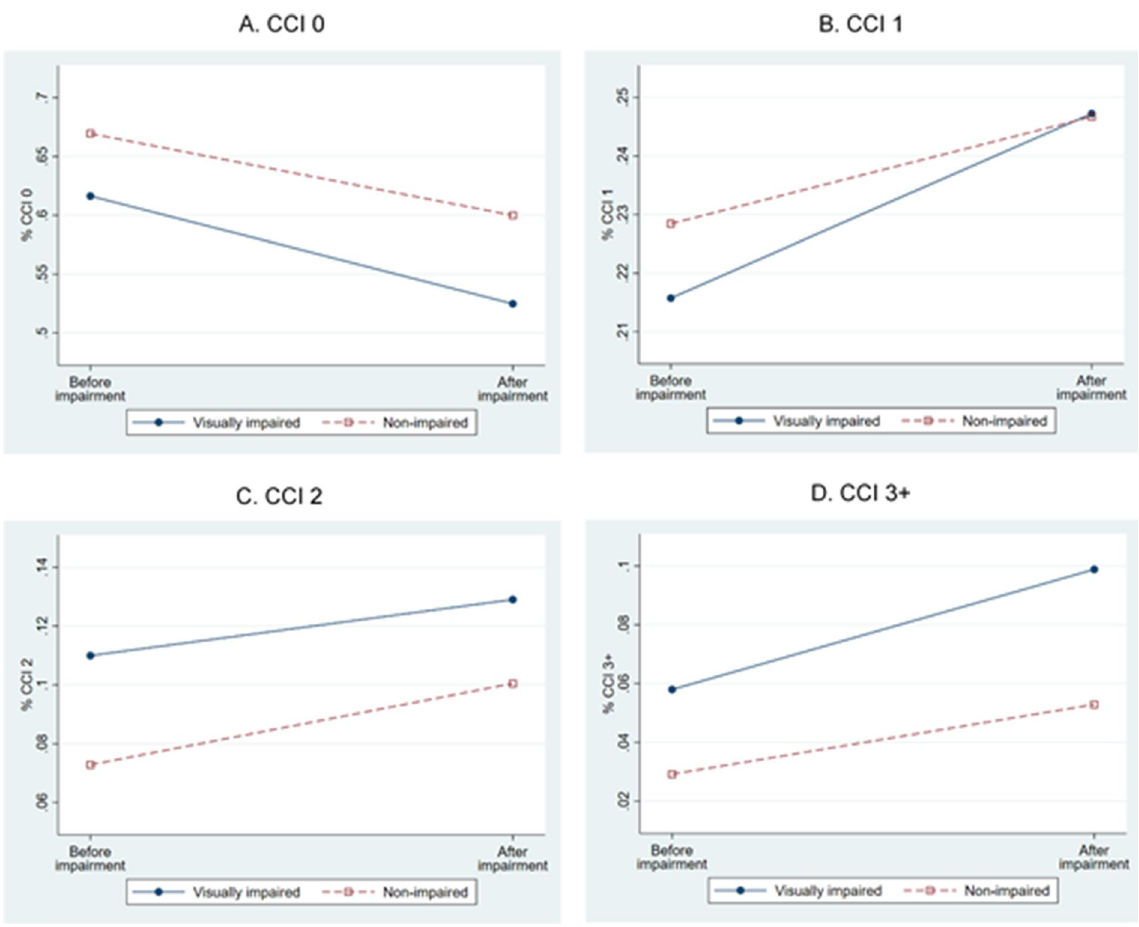
Figure 2. Proportion change of CCI by visual impairment.